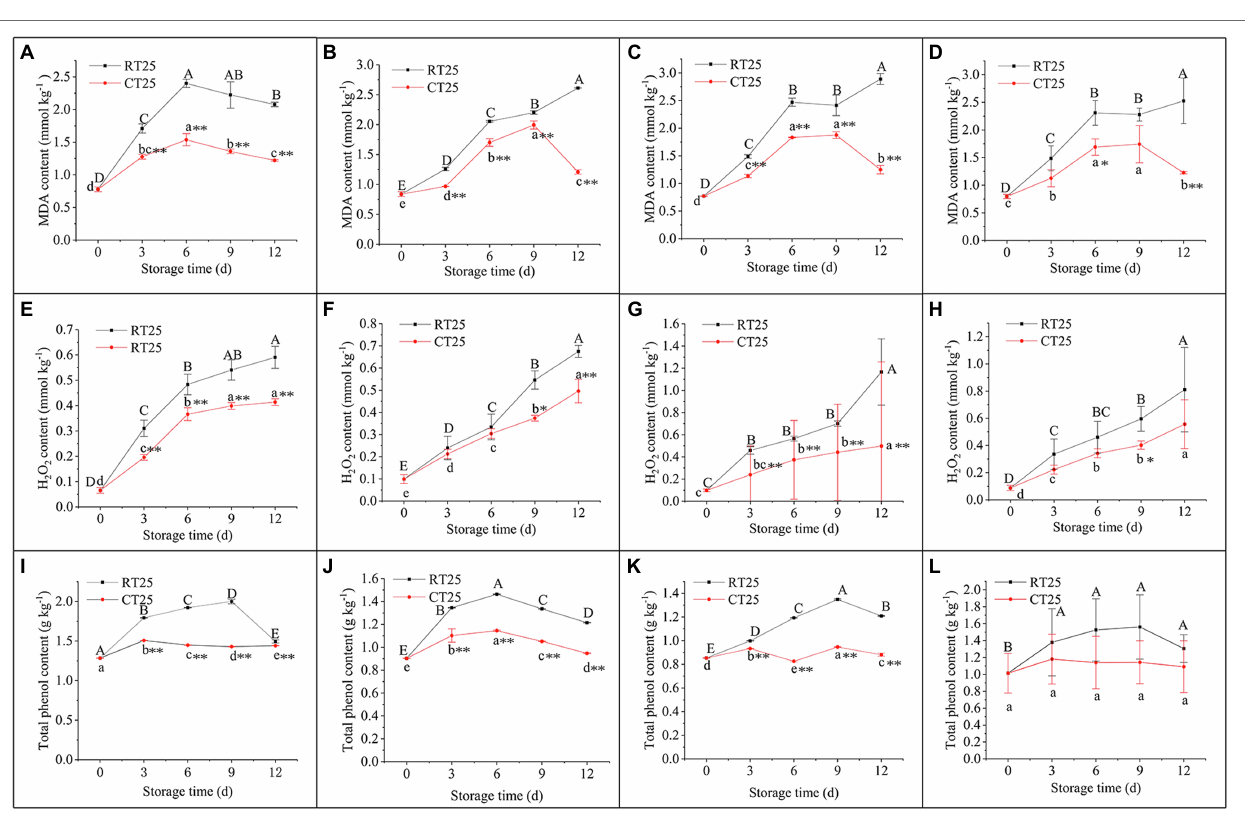
FIGURE 9 | Dynamic changes in MDA, H 2 O 2 , and total phenol content in bamboo shoots after storage at 25 ° C and 4 ° C. RT25, bamboo shoots stored at room temperature and analyzed at 25 ° C; CT25, bamboo shoots stored at cold temperatures and analyzed at 25 ° C. (A–D) MDA content in shoots during storage for upper (A) , middle (B) , and bottom (C) plant parts, and mean values (D) . (E–H) H 2 O 2 content in shoots during storage for upper (E) , middle (F) , and bottom (G) plant parts, and mean values (H) . (I–L) Total phenol content in shoots during storage for upper (I) , middle (J) , and bottom (K) plant parts, and mean values (L) . Data are presented as mean ± standard deviation ( n = 3). Significant analysis was performed using the Student’s t -test, in which different letters represent significant difference between treatments within the group, and the asterisk represents the level of significance between groups ( * means the difference is significant at the 0.05 level, ** means the difference is significant at the 0.01